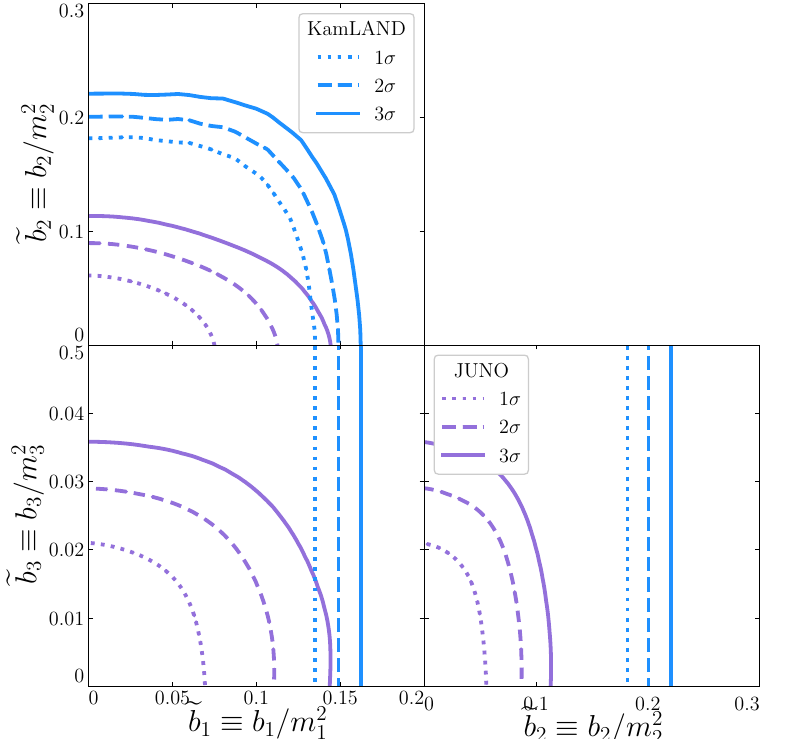
Figure 10. Expected future constraints by JUNO (purple) in the absence of a new-physics signal in the parameter space of ˜ b i , compared against the current constraints from KamLAND (blue). Compared to figure 9, the data range here is so narrow that the constraints from Daya Bay, T2K, and NOvA do not